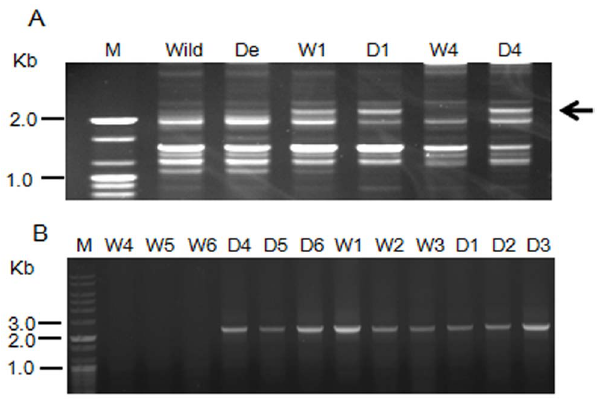
Figure 4. PCR-amplification products of the RAPD and SCAR primers. (A) RAPD electrophoretic profile of monokaryons of the wild- type and degenerate strains obtained using random primer OPD-05. The arrows indicate the polymorphic bands of the wild-type (W4) and degenerate monokaryons (D4). (B) Specificity of the FEDE primer set (SCAR marker). Wild: Fv1-5 (wild-type), De: Fv1-5 d (degenerate). W1 to W6 are monokaryons from Fv1-5, and D1 to D6 are monokaryons from Fv1-5 d . W1-W3: group a ( AxBy ), W4-W6: group b ( AyBx ), D1-D3: group a d ( AxBy ), and D4-D6: group b d ( AyBx ).